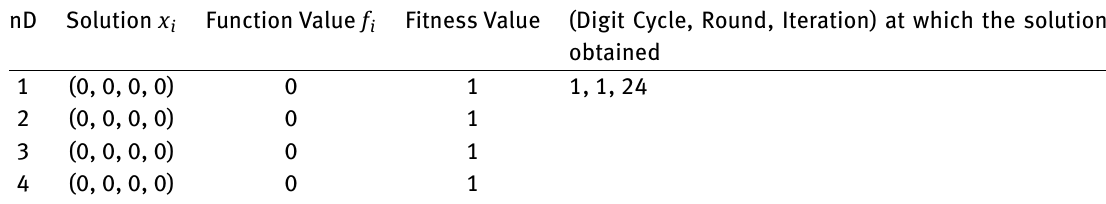
Table 26: Digit Cycle Results for Powel’s function with 4 variables nD